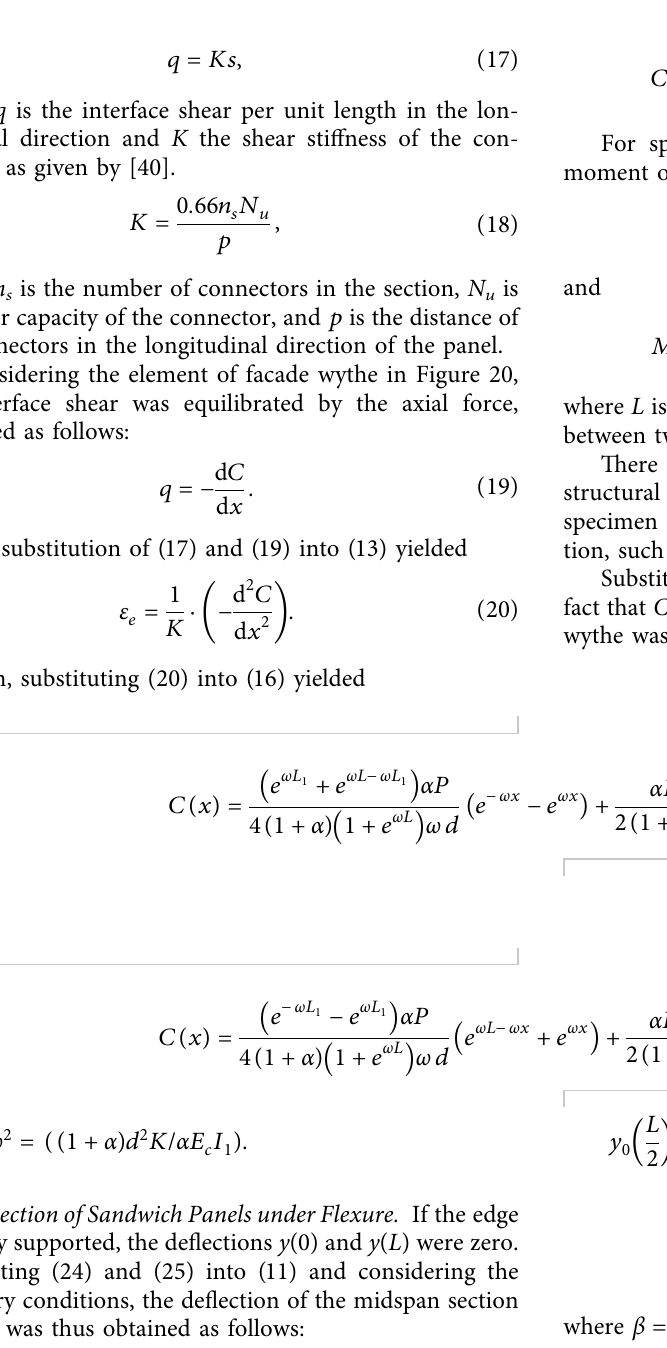
Figure 19: Distribution of strain and forces of sandwich